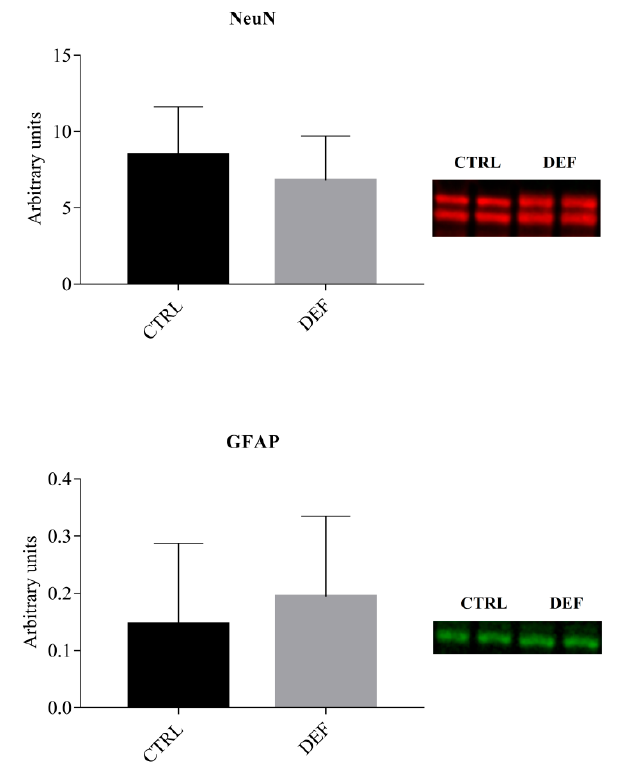
Figure 1. Cellular markers in the hippocampus. The figure depicts the Western blot analyses of the levels of the investigated cellular markers in the hippocampus relative to total protein levels. The two bands in the NeuN samples are consistent with splice variants (confirmed by the manufacturer). No differences between the two groups were detected by Student’s t -test. Data is shown as mean ± SD, SD: standard deviation. GFAP: Glial-fibrillary-acidic-protein, NeuN: Neuronal nuclei marker. CTRL: Control animals ( n = 13), DEF: Deficient animals ( n =